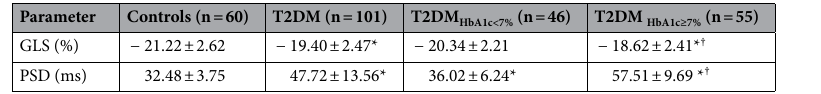
Table 3. Impairment of GLS and PSD parameters in the LV in T2DM patients. Data are represented as the mean ± SD. GLS global longitudinal strain, PSD peak strain dispersion. * p < 0.05 versus control. † p < 0.05 versus controlled blood glucose.